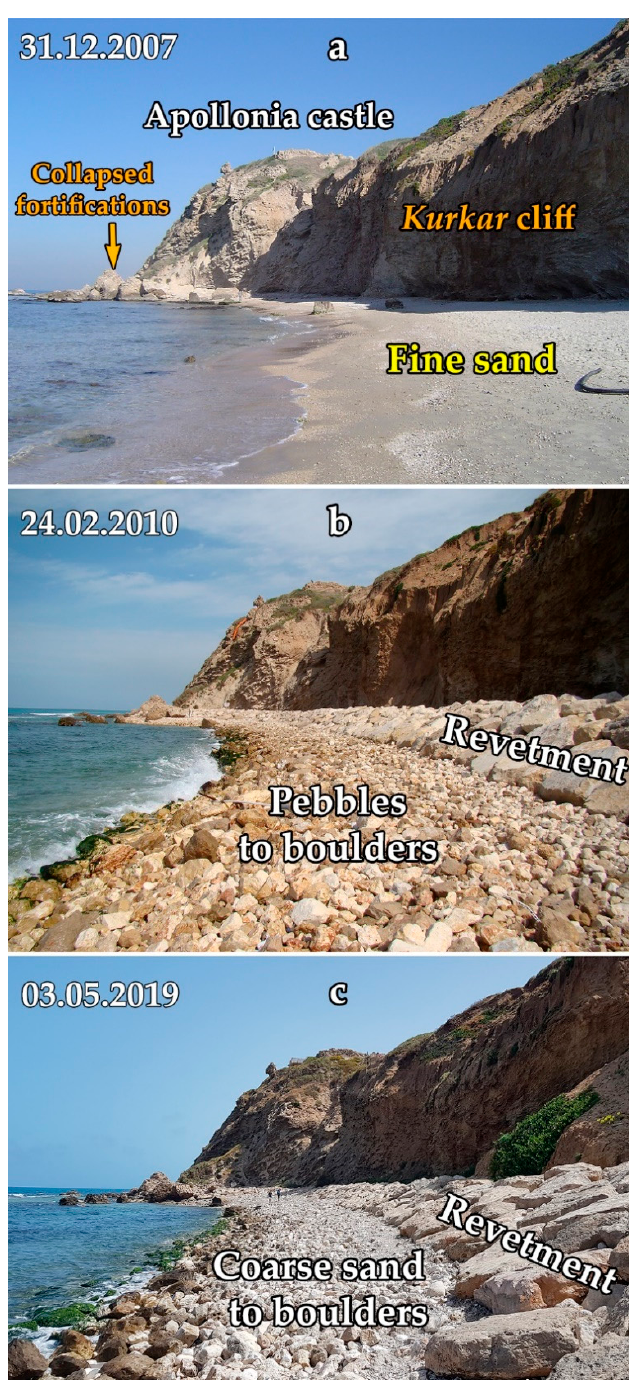
Figure 6. The Apollonia site (Crusader castle) coast and the main part of the nourished coast at the cliff toe: ( a ) about two years before nourishment operation (i.e., October 2009); ( b ) four months after the coast was nourished by pebbles, cobbles, and boulders; and ( c ) about 10 years after nourishment. (All images photographed by Dov Zviely).